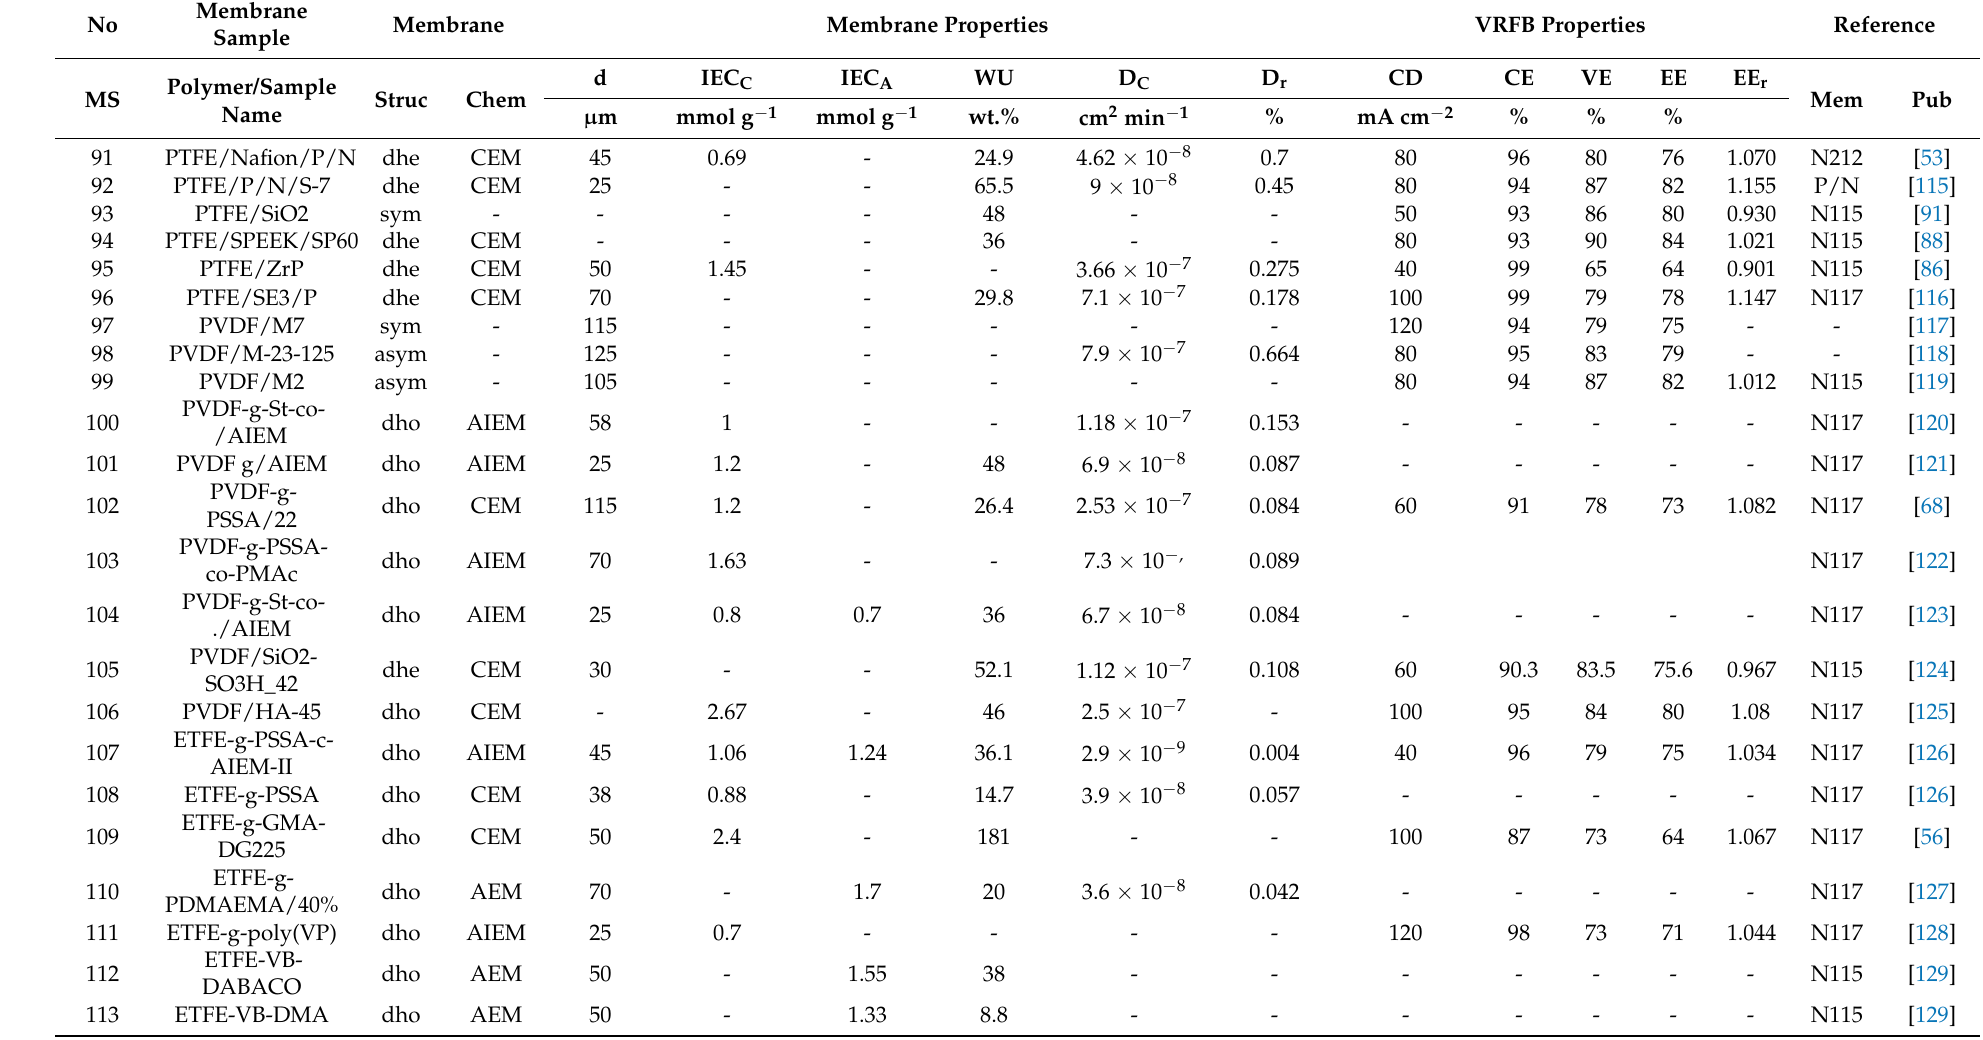
Table 5. List of fluoro-carbon membrane